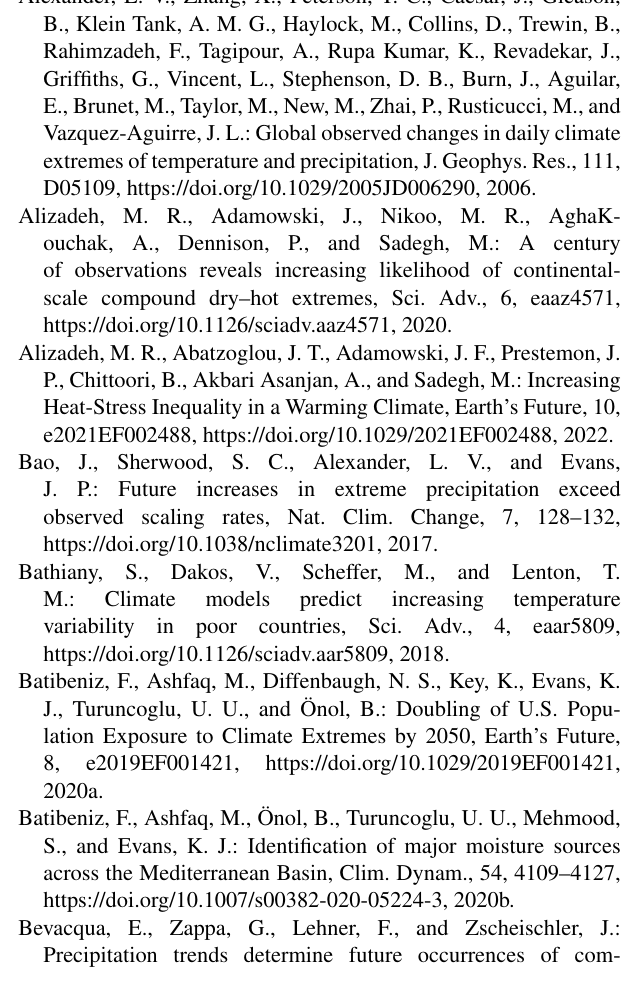
Figure B3. Population from GWPv4 at (a) 2.5 ◦ grid level and (b) country